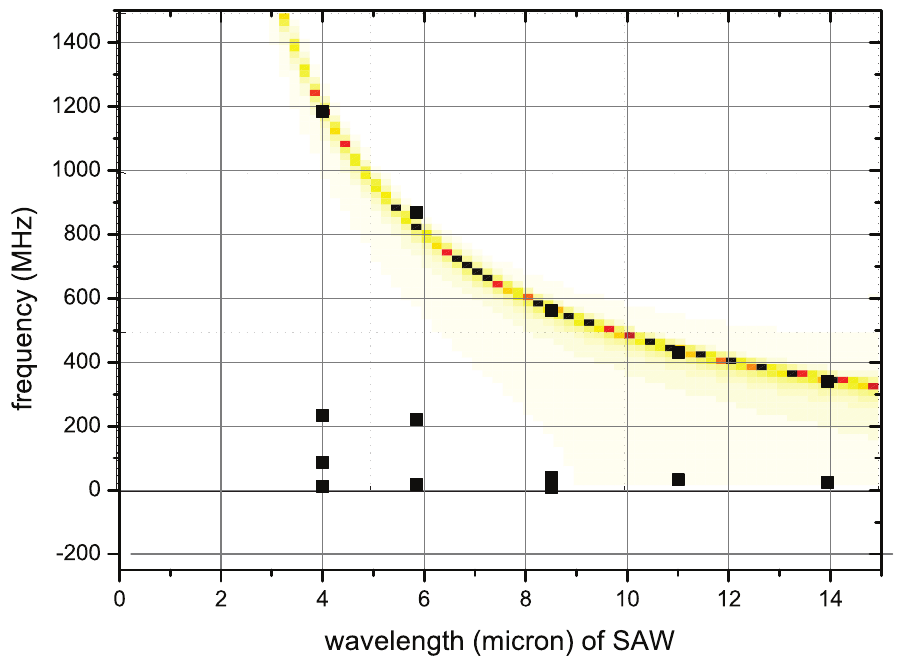
Figure 6. Validating example for the test sample Ni/Si. Calculated within the model developed dispersion curve of the only Rayleigh-like SAW indicated by the ridge in the | K 33 | level-line image (yellow) passes through the TGM measured points (markers); low-frequency markers ( f < 250 MHz) are just hardware